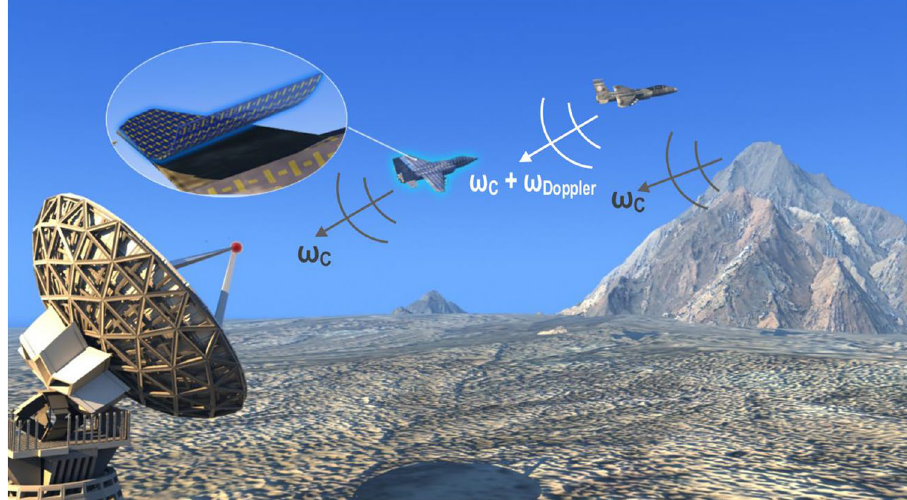
Figure 1. Illustration of the proposed invisibility concept. Two airplanes and a mountain are shown reflecting echoes back into the interrogating radar. The left plane is coated with a special metasurface, which dynamically controls the phase of the scattered electromagnetic pulse back into the radar. Temporal modulation of the metasurface causes the reflected phase to remain unchanged in time, even though the airplane is moving. This serves to conceal the Doppler signature of the aircraft, making it appear as stationary as the surrounding clutter (i.e. the ground or the mountains near the radar). This causes the radar to filter out the cloaked target together with the stationary clutter, rendering it invisible. The second airplane appears clearly against the backdrop of the mountains, even though it is a much smaller scatterer, due to the fact it can be detected using its Doppler